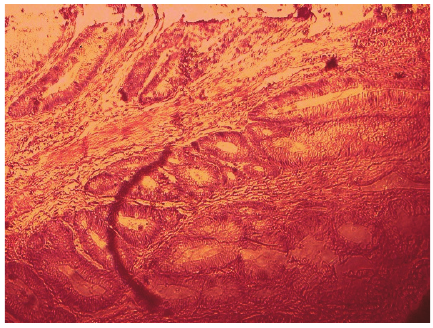
Figure 2: Tubular adenoma (case 1)—low